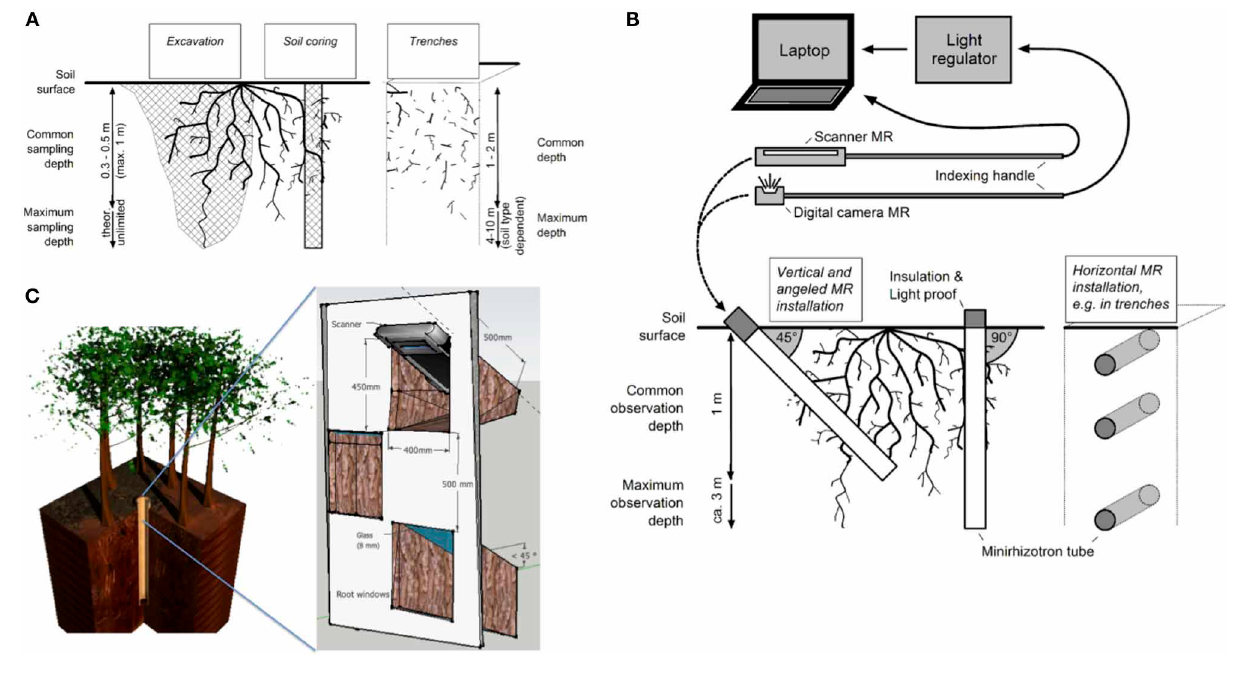
FIGURE 2 | (A–C) Illustrations of some direct field methodsto access (deep) root systems. (A) Excavation, soil coring and soil trenchingtechniques. (B) Minirhizotron(MR) techniqueswith imageacquisition devices(i.e.,Digital Cameraor Scanner MR) and different optionsto install the MR tubes, i.e.,